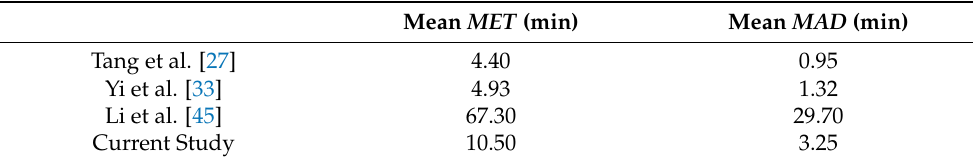
Table 3. The mean METs and mean MADs in the literature and in the current study.